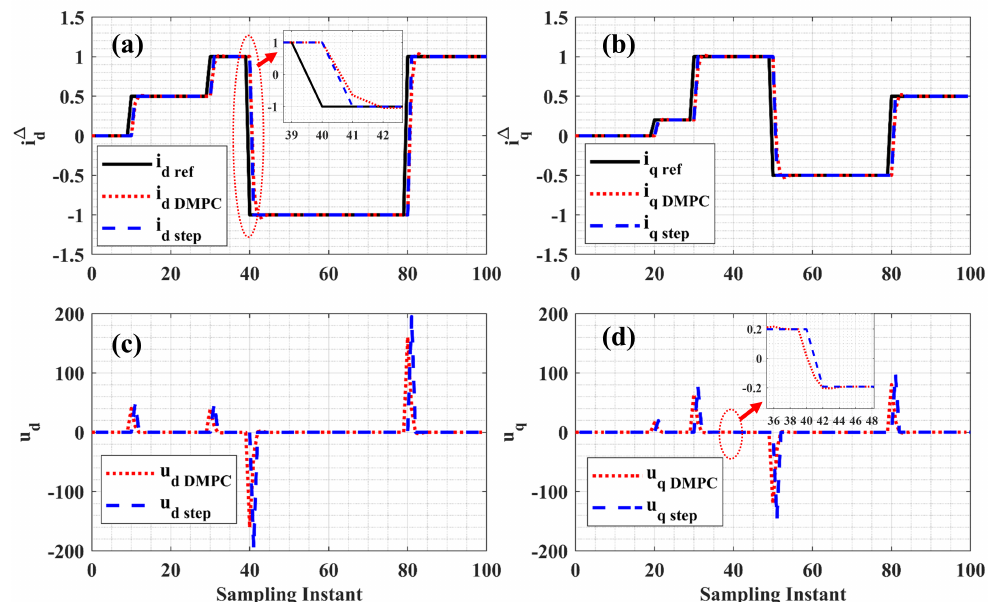
Figure 13. Case- study with unconstrained scenario: ( a ) i ∆ ( d ) u q voltage.